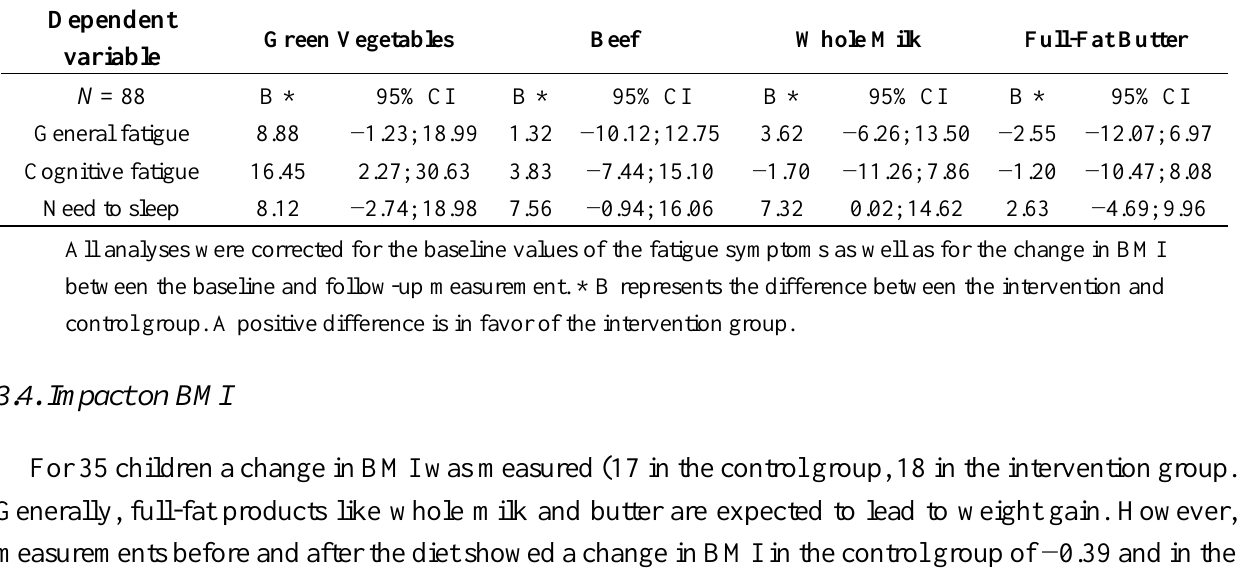
Table 4. Analysis of Covariance of the effect of components of the diet on symptoms of fatigue. Dependent Green Vegetables Beef Whole Milk Full-Fat Butter variable N = 88 B * 95% CI B * 95% CI B * 95% CI B * 95% CI General fatigue 8.88 −1.23; 18.99 1.32 −10.12; 12.75 3.62 −6.26; 13.50 −2.55 −12.07; 6.97 Cognitive fatigue 16.45 2.27; 30.63 3.83 −7.44; 15.10 −1.70 −11.26; 7.86 −1.20 −10.47; 8.08 Need to sleep 8.12 −2.74; 18.98 7.56 −0.94; 16.06 7.32 0.02; 14.62 2.63 −4.69;